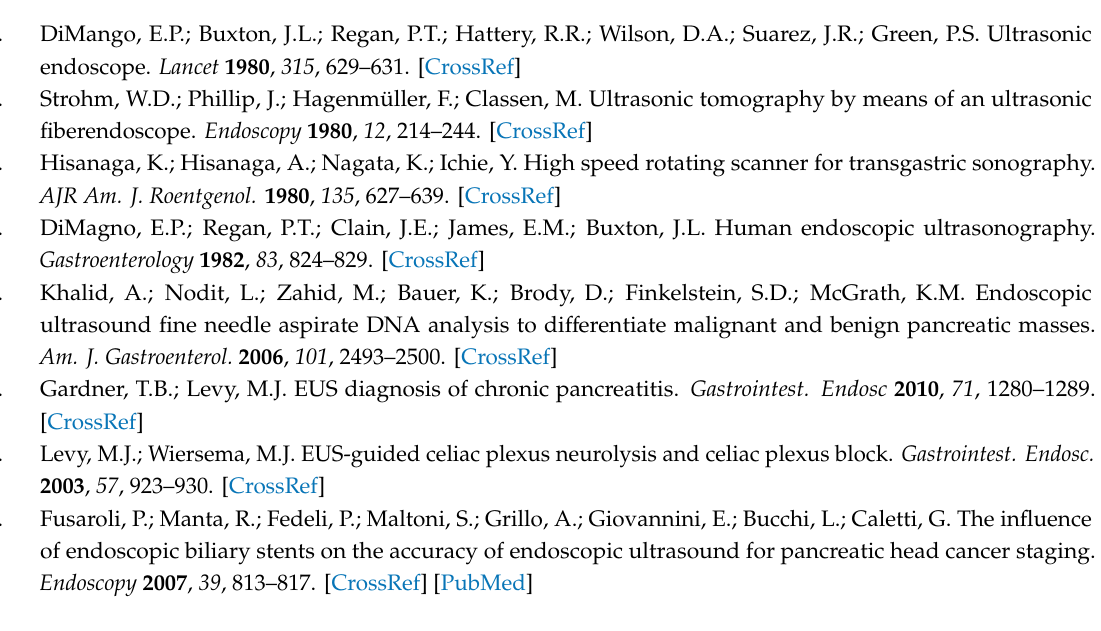
Table S1: Endoscopic ultrasound criteria for the diagnosis of chronic pancreatitis, Table S2: Classification of patients based on endoscopic